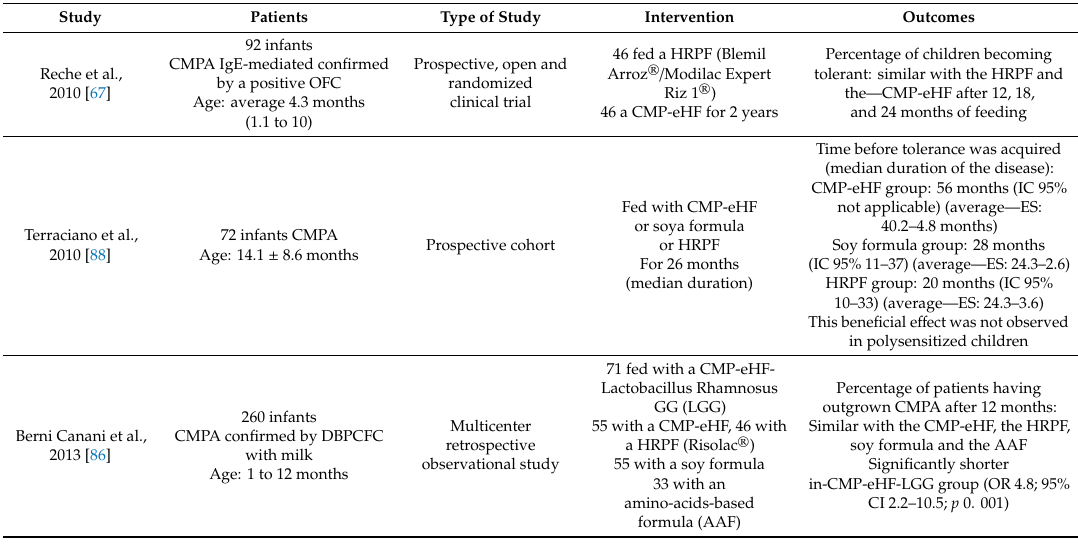
Table 7. The duration of CMPA in infants fed with